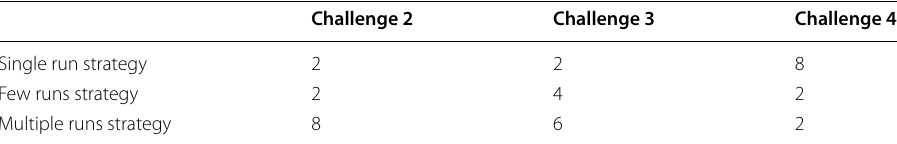
Table 4 Number of students using a strategy in each Design Tracing Stage challenge based on their interaction